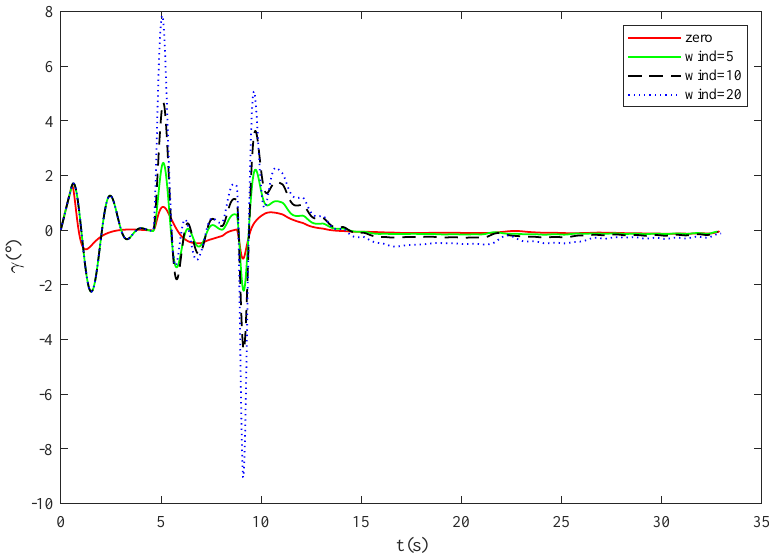
Figure 10. Change curve of roll angle rate under wind disturbance.